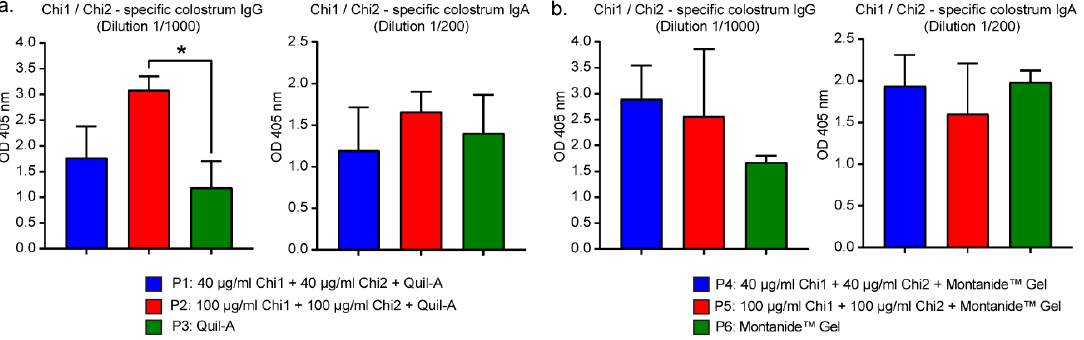
Figure 3. Chi1/Chi2—specific antibody levels in colostrum. ( a ) Colostrum from P1, P2 and P3 groups. ( b ) Colostrum from P4, P5 and P6 groups. Data analysis was by Kruskal − Wallis test, fol ‐ lowed by Dunn’s multiple comparison test. p < 0.05 was considered significant. * p < 0.05.